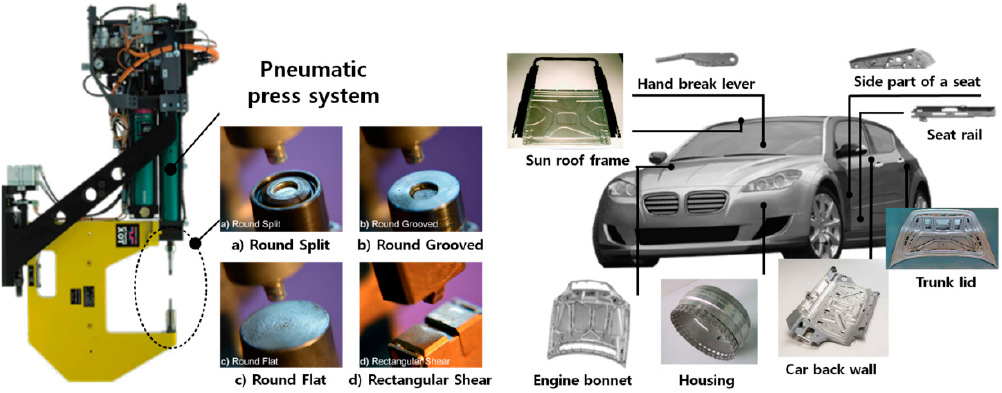
Figure 2. Mechanical clinching facility and its applications in automotive fabrication.